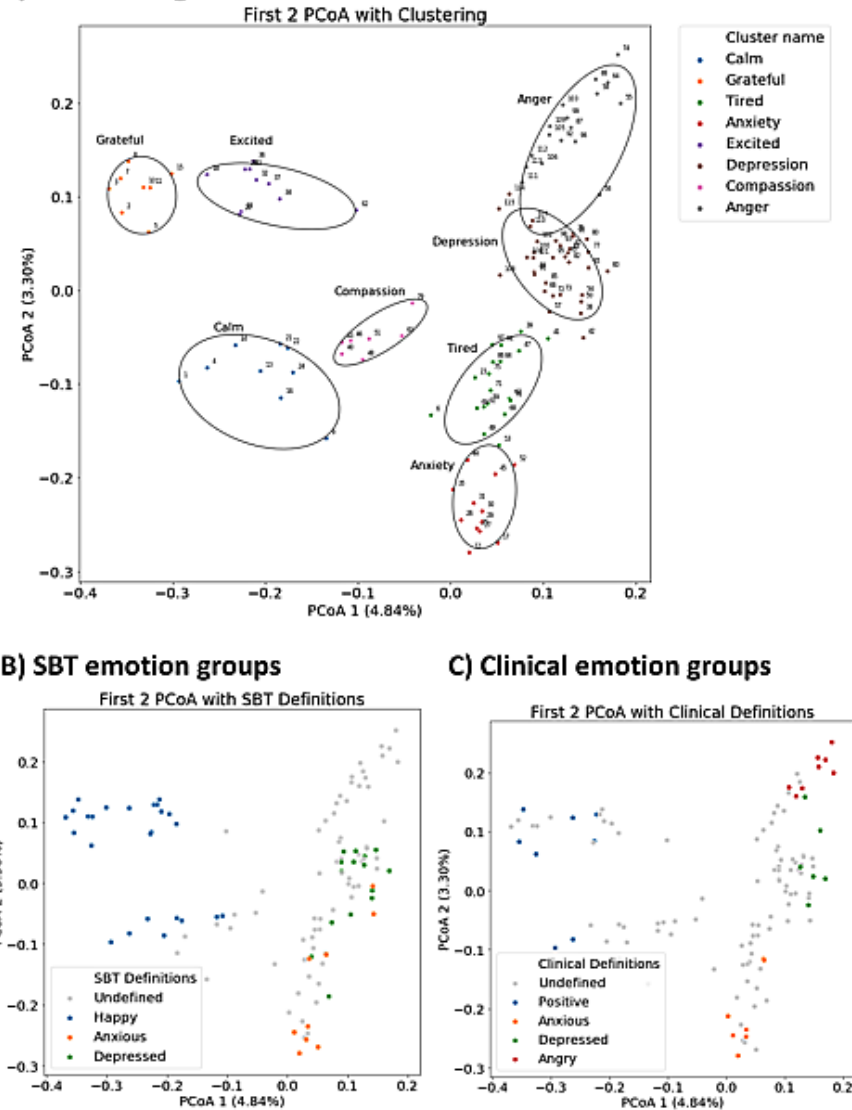
Figure 3. Emotional clustering on co-selected terms. Emotional clusters created from coselected terms within the same check-in (see text), are defined using PAM and silhouette scores. Each point represents an emotion that can be endorsed, and can be looked up in corresponding table. (A) The optimal 8 clusters are shown across the first 2 principal coordinate analyses (PCoAs). Clusters are given labels based on a single emotion that is thematic to most emotions within the cluster. (B) In-house, defined emotional labels show consistent grouping within the first 2 PCoAs. (C) Clinically defined emotional labels show consistent grouping within the first 2